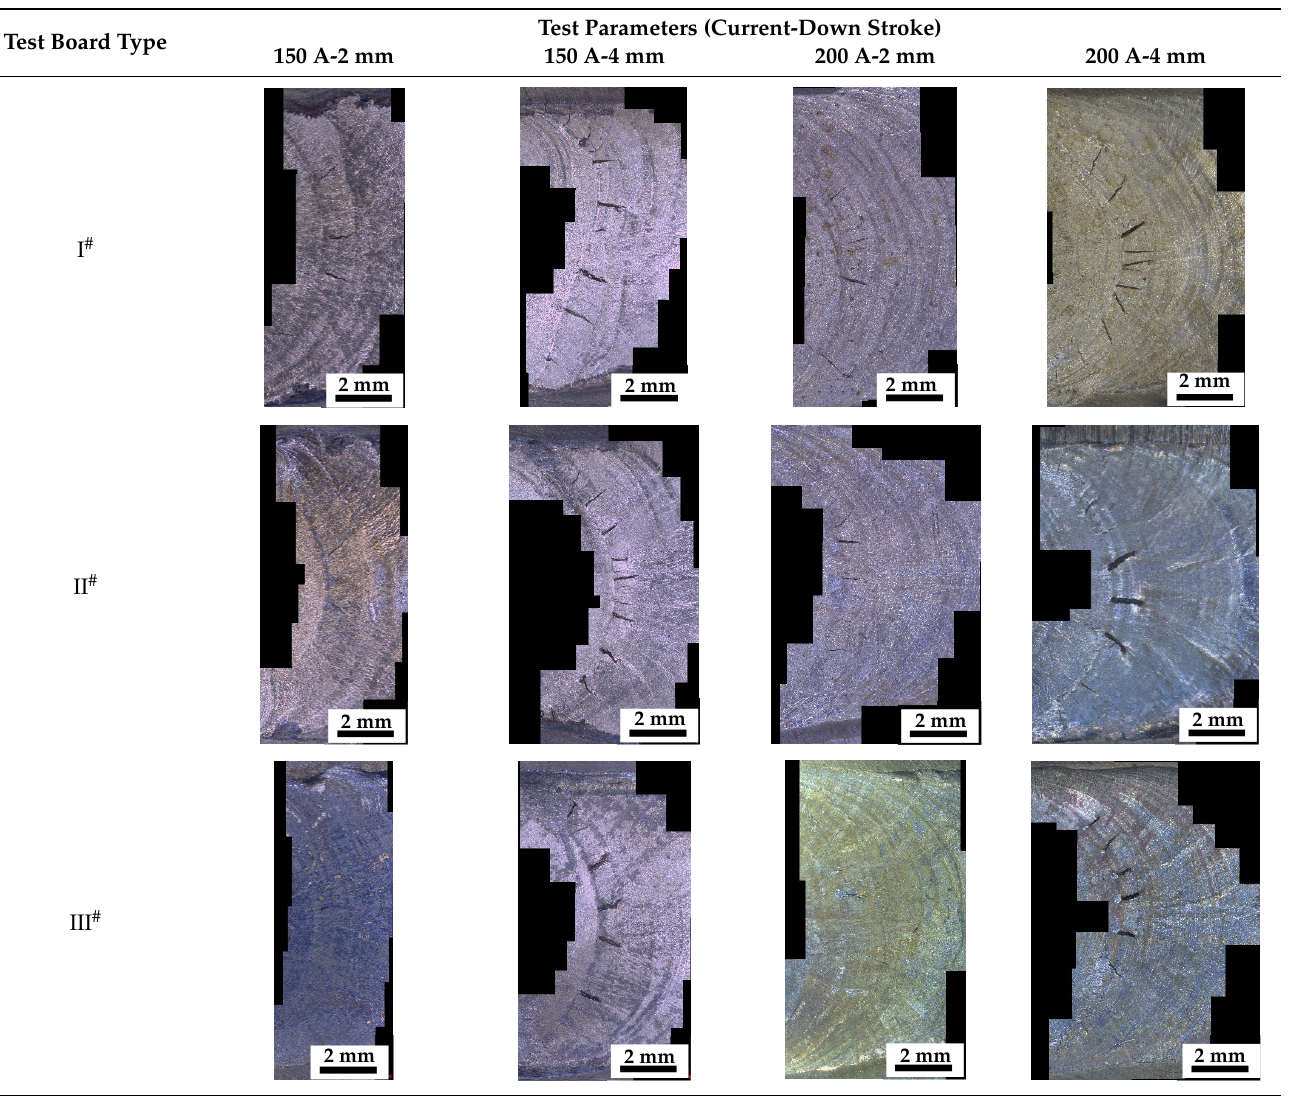
Figure 3a. A number of cracks appear between the red curves, which indicate the edge of the molten pool. During the test, this region was undergoing the solidification process with the strain applied, implying that it is a typical SFC initiation place. Conversely, the